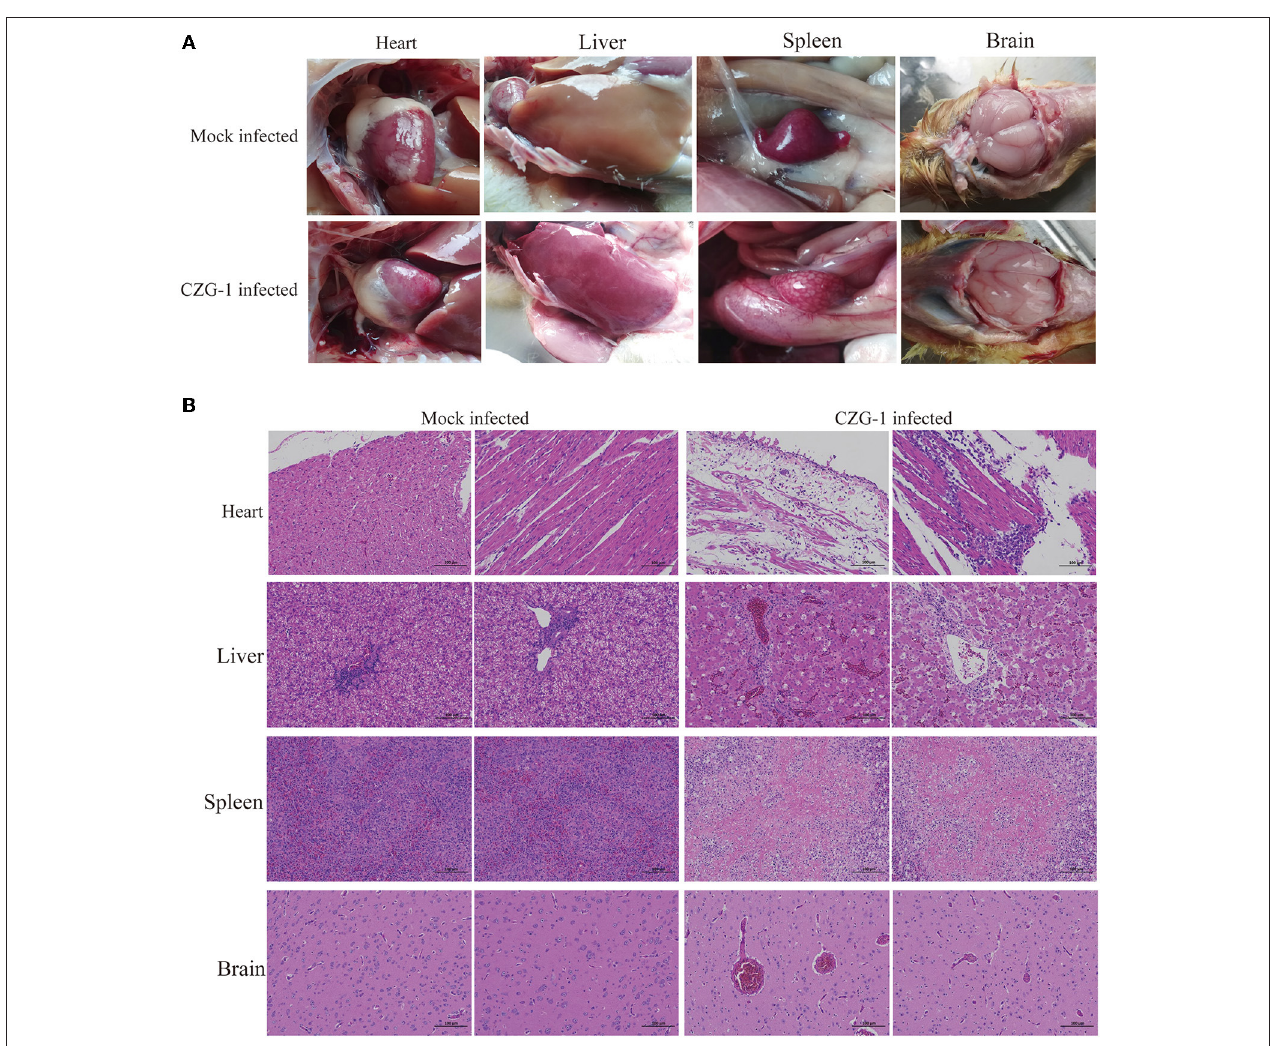
FIGURE 3 | Autopsy and pathological sections of tissues after CZG-1 infection. (A) Autopsy results of normal and dead ducks infected with CZG-1 strain. (B) Pathological section results of tissues collected from normal and dead ducks.